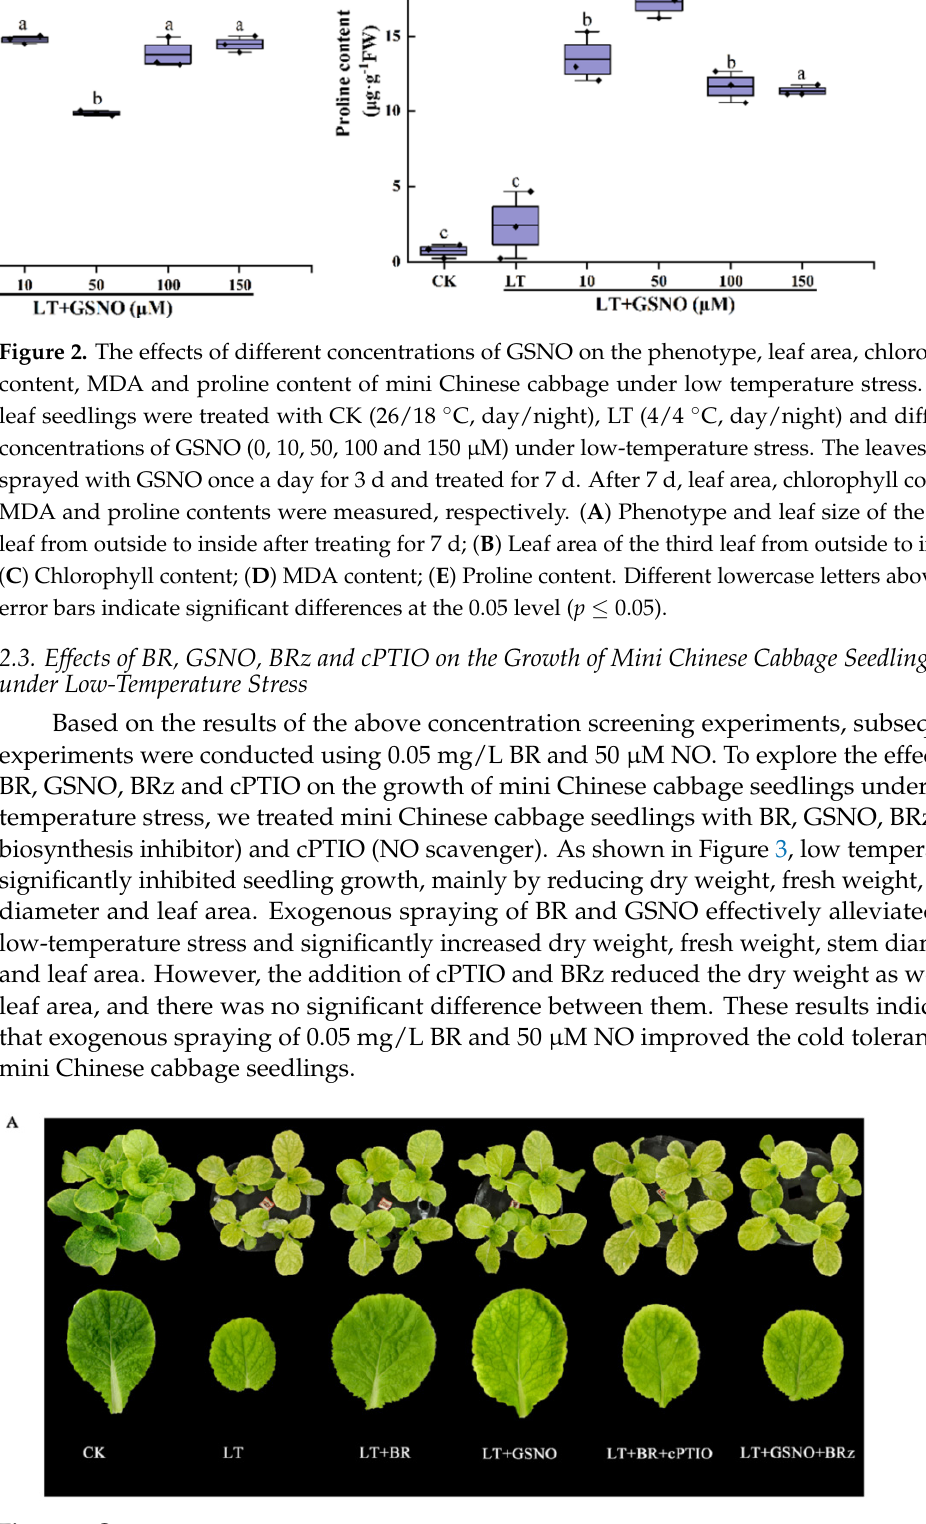
Figure 3. Effects of BR, GSNO, cPTIO and BRz treatments on fresh weight, dry weight, stem diam- eter and leaf area of mini Chinese cabbage under low temperature stress. Five-leaf seedlings were treated with CK (26/18 °C, day/night), LT (4/4 °C, day/night), LT + 0.05 mg/L BR, LT + 50 µM GSNO, LT + 0.05 mg/L BR + 50 µM cPTIO and LT + 50 µM GSNO + 10 µM BRz, cPTIO and BRz were sprayed separately, and then BR and NO were sprayed after an interval of 5 h, once every day for 3 d and treated for 7 days. After treating for 7 d, fresh weight, dry weight, stem diameter and leaf area were measured, respectively. ( A ) Phenotype and leaf size of the third leaf from outside to inside after treating for 7 d; ( B ) Fresh weight; ( C ) Dry weight; ( D ) Stem diameter; ( E ) Leaf area. Different low- ercase letters above the error bars indicate significant differences at the 0.05 level ( p ≤ 0.05). 2.4. Effects of BR, GSNO, BRz and cPTIO on Endogenous NO and SNO Levels under Low- Temperature Stress To explore the upstream or downstream relationship between BR and NO in the pro- cess of alleviating low-temperature stress by regulating S -nitrosylation in vivo, the endog- enous NO and SNO levels were measured. The changes in NO content in the leaves of